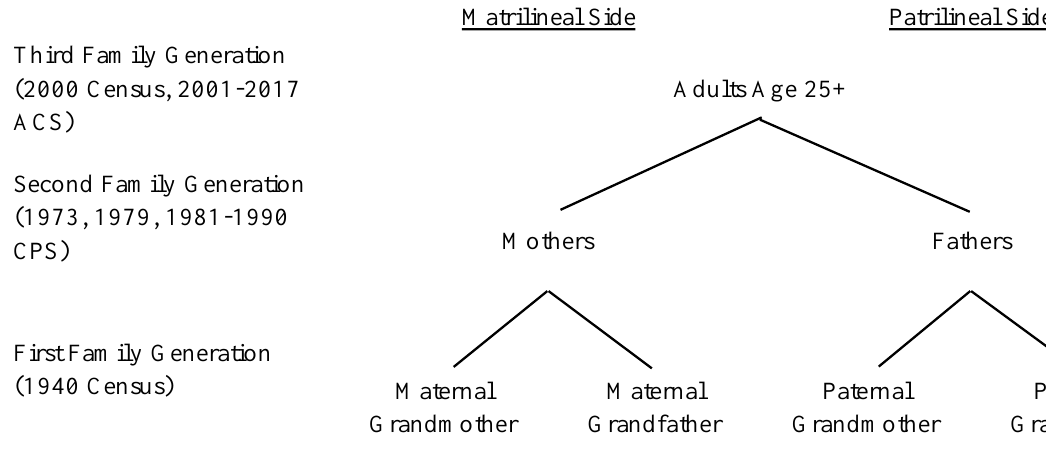
Figure 1: Family members in sample (from perspective of contemporary Figure 1. Family Members in Sample (from perspective of contemporary adults)